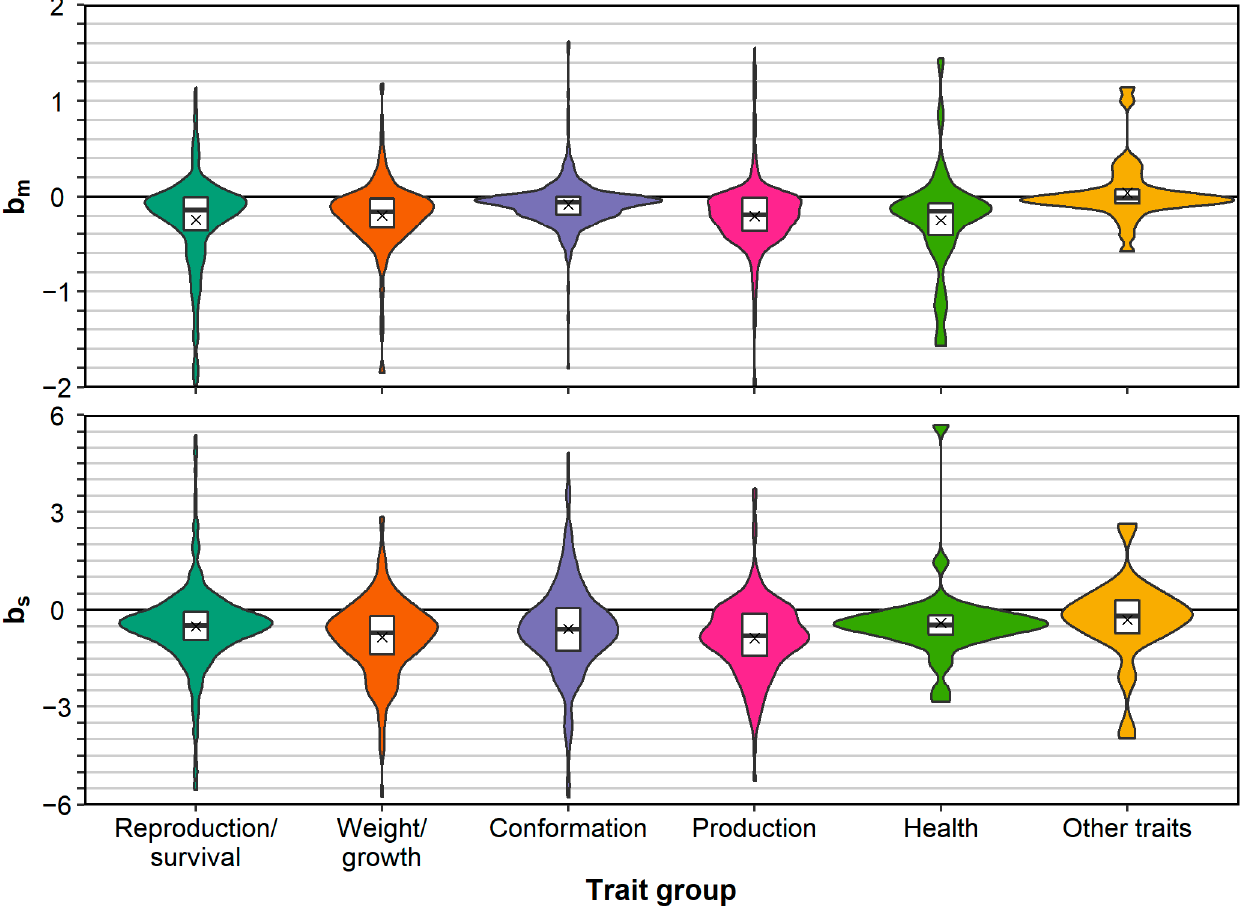
Figure 2. Violin plots of inbreeding depression estimates per trait group. Estimates are expressed as a percentage of a trait’s mean ( b m ) or as a percentage of a trait’s SD ( b s ). Boxplots are also shown, indicating the median, 25th and 75th quantiles and the mean ( × ) for each group. For b m and b s , there were respectively 40 and 39 extreme estimates outside the range of this figure. Table 1. Estimated marginal means of inbreeding depression estimates per trait group with standard errors (SEs). Inbreeding depression estimates are expressed as percentage of a trait’s mean ( 𝑏 (cid:3040) ) or as percentage of a trait’s SD ( 𝑏 (cid:3046) ). The number of estimates (N) and the p -value for testing the mean against zero are also shown.